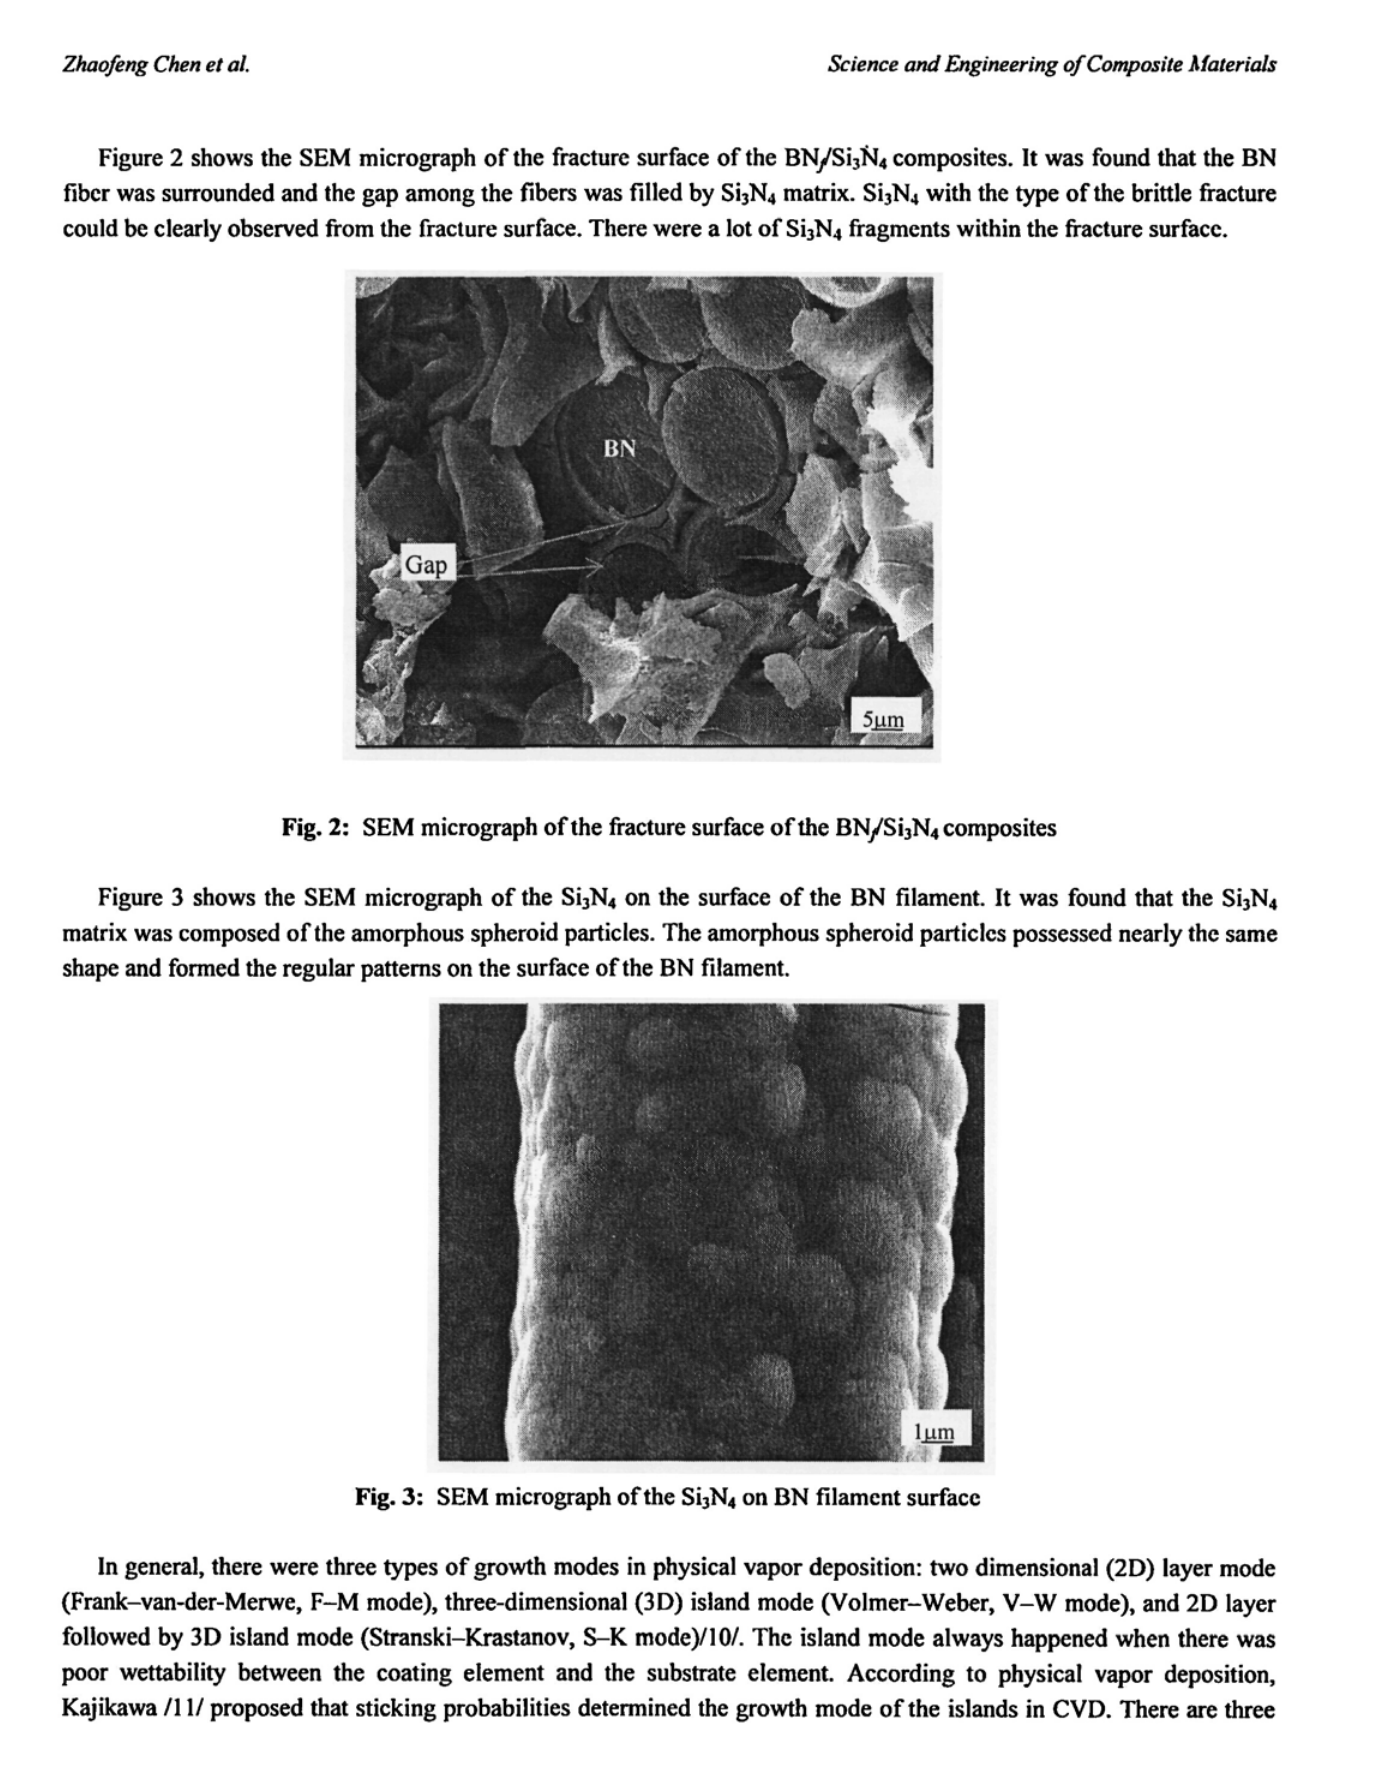
N on BN filament 3 4